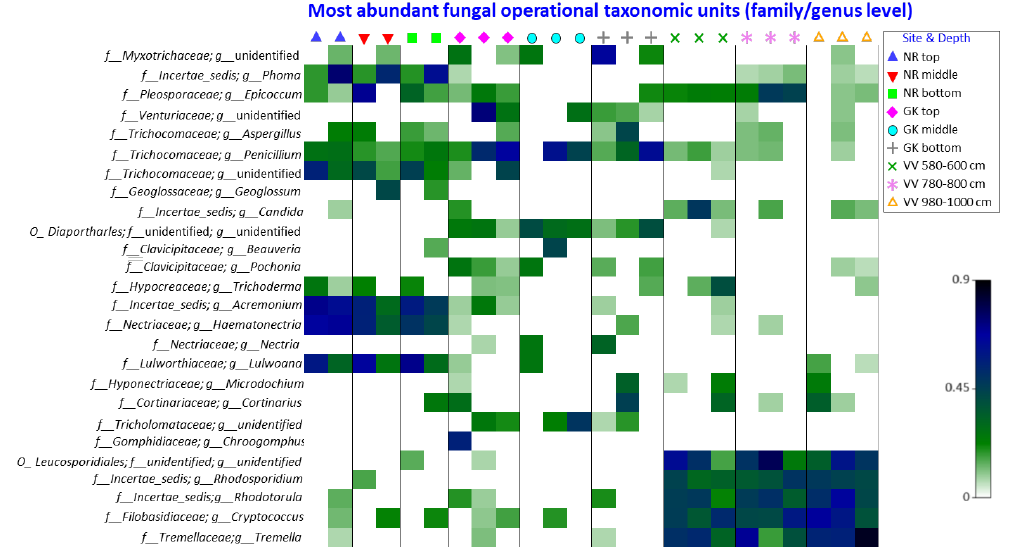
Figure 3. Shade plot of square root transformed relative abundance of the most abundant fungal operational taxonomic units in the peat samples. NR = Nuwejaars River system (developing peatland); GK = Goukou River system (impacted peatland); VV = Vankervelsvlei (undisturbed peatland); Top: samples from 0 to 5 cm depth; middle: samples from 25 cm depth; bottom: samples from 50 cm depth.